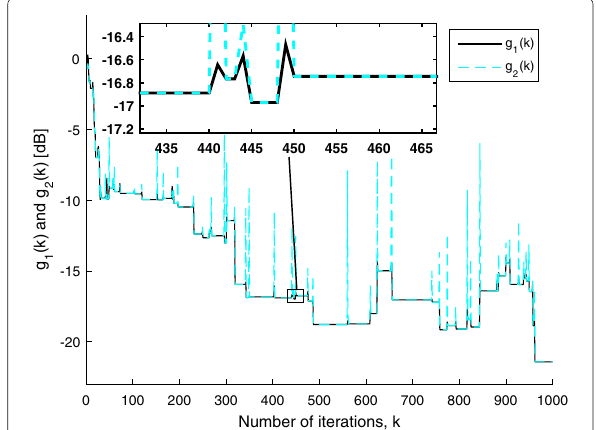
Fig. 4 Values of g 1 ( k ) and g 2 ( k ) over the iterations for the SM-AP algorithm with γ ( k ) as the SC-CV, where g 1 ( k ) and g 2 ( k ) are the numerator and denominator of (26) in Theorem 3, when an update occurs; otherwise, g 1 ( k ) = (cid:3) ˜ w ( k + 1 ) (cid:3) 2 and g 2 ( k ) = (cid:3) ˜ w ( k ) (cid:3)